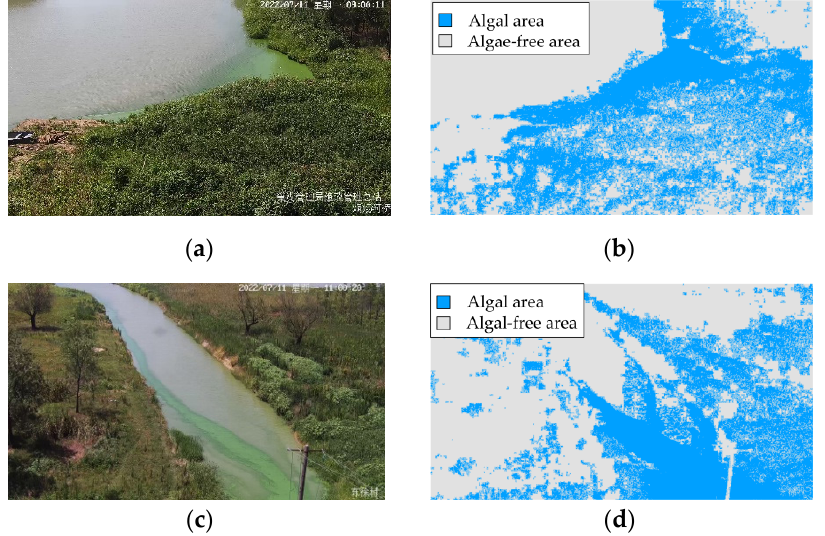
Figure 1. Extraction result of algal blooms based on video images: ( a , c ) original video images; ( b , d ) results of algal-bloom extraction.